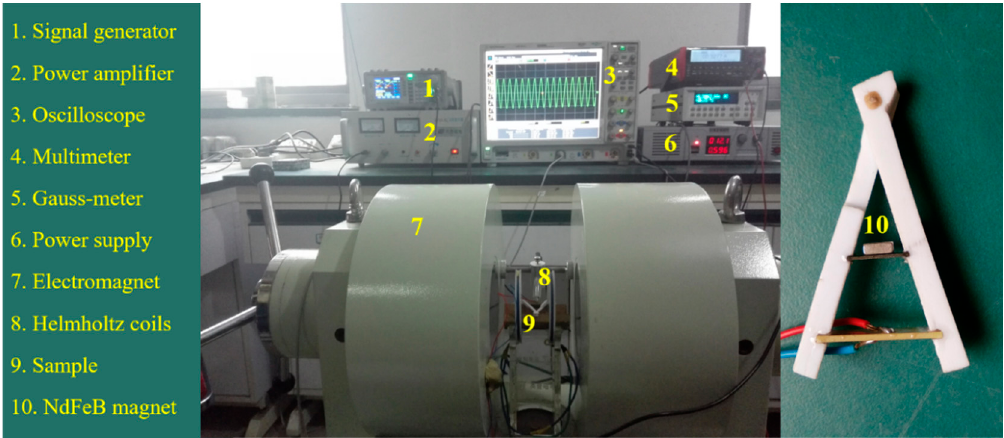
Figure 3. Physical drawing of ME test system.